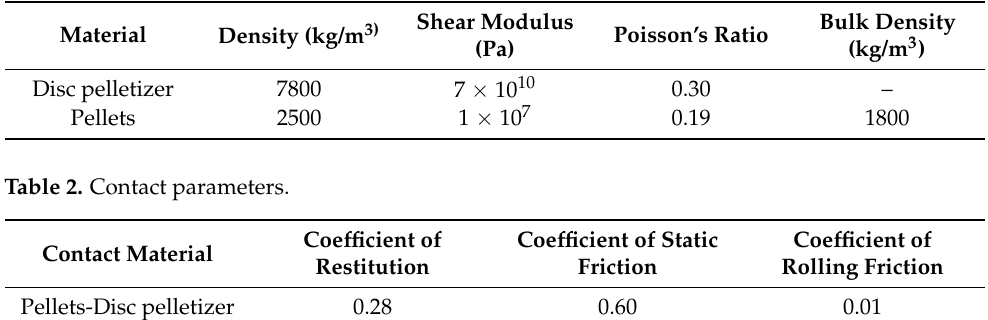
Table 1. Material physical parameters.